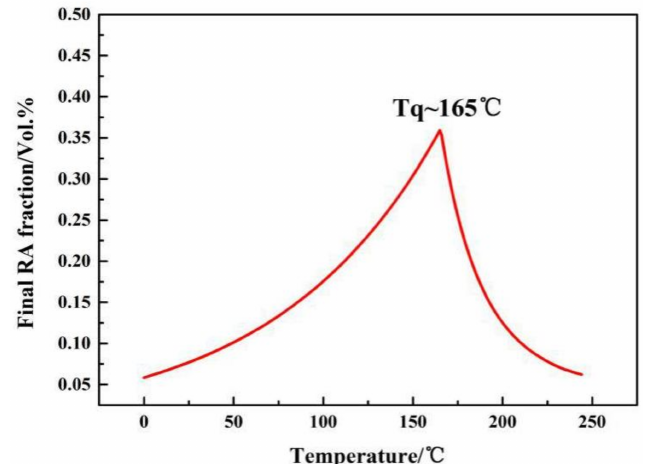
Figure 2. Predicted RA fraction according to Speer et al. theory. Samples for microstructural characterization were grinded, polished, and etched in a 4% nital solution. Microstructures were observed by ZEISS metallographic microscope (Carl Zeiss AG, Oberkochen, Germany) and FEI Nova 400 Nano SEM field emission scan- ning electron microscope (Royal Dutch Philips Electronics Ltd., Amsterdam, Netherlands) after etching in a 4% nital solution. Transmission electron microscope (TEM), JEM-2100F (JEOL, Tokyo, Japan), was also used to characterize the microstructure of the samples, which were prepared by grinding and polishing down to a thickness of about 50 µ m, followed by double-jet thinning at − 25 ◦ C with operating voltage of 32 V using 10 vol.% perchloric acid